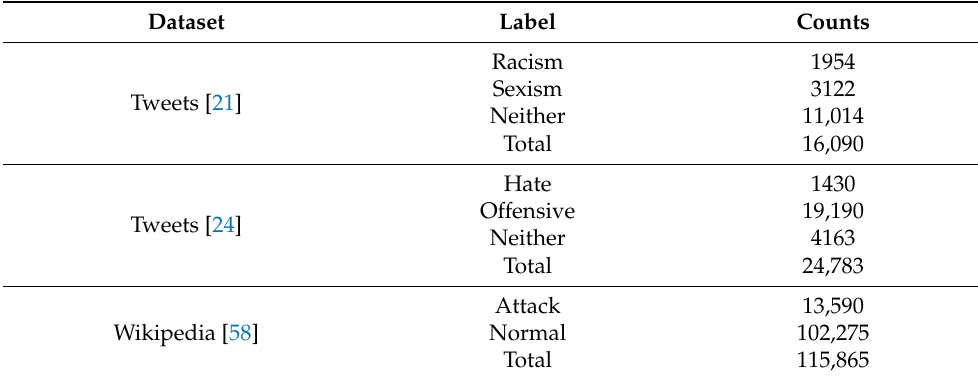
Table 1. The statistics of original datasets.